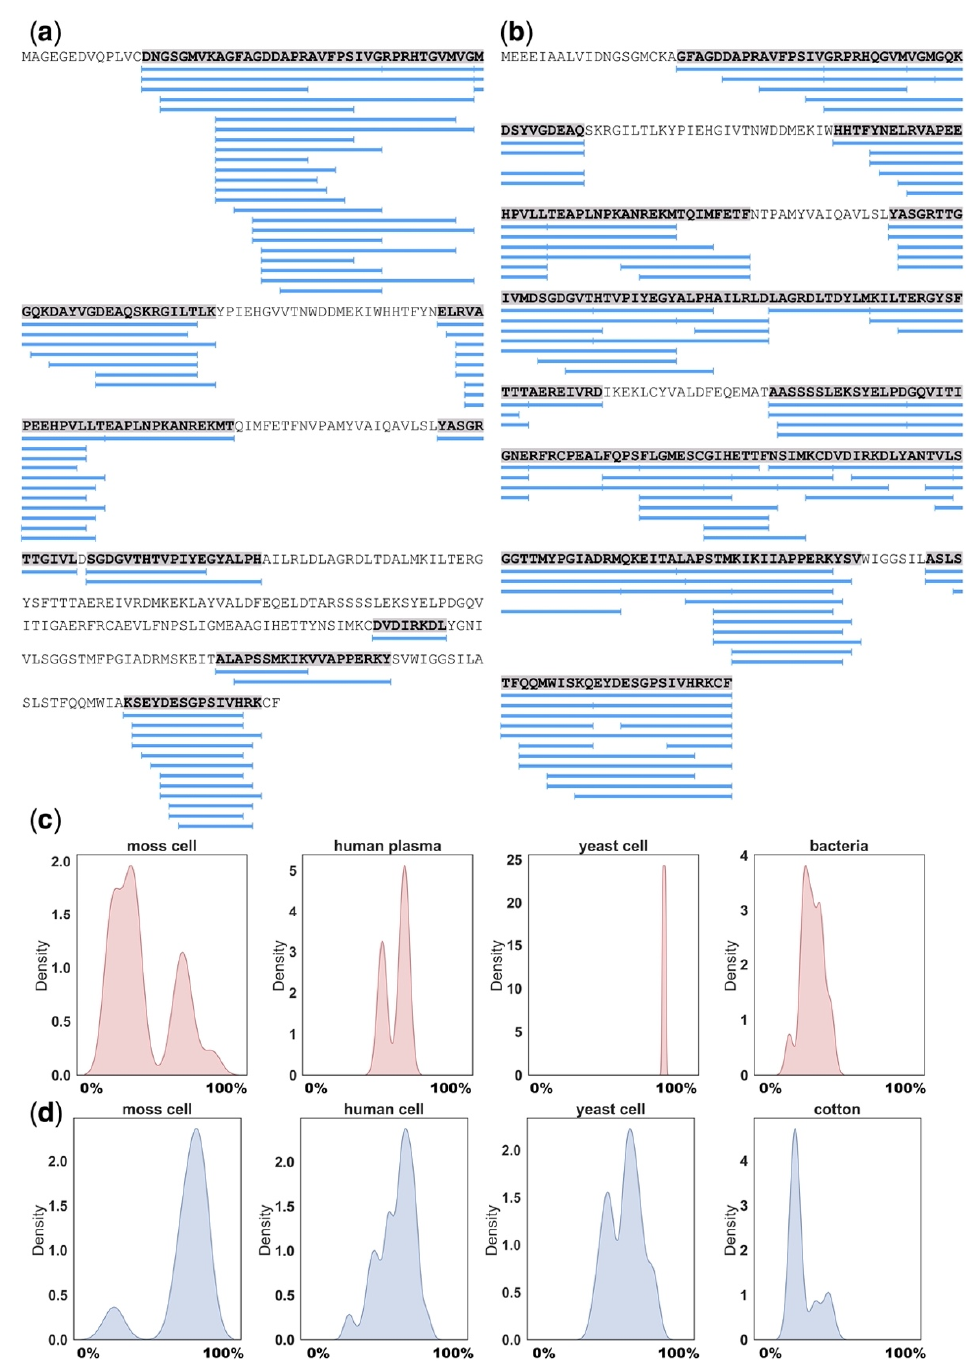
Figure 4. Examples of functional protein degradation patterns. ( a ) MS-identified naturally occurring peptides from P.patens actin (UniProt ID: A9TBG2) and ( b ) human actin (UniProt ID: P63261); density plot showing the MS-based degradation patterns of ( c ) mitochondrial ATP synthase subunit and ( d ) glyceraldehyde-3-phosphate dehydrogenase proteins from the moss P.patens , human, yeast Saccharomyces cerevisiae , bacteria Lactococcus lactis and cotton Gossypium arboreum . These patterns are presented as distribution of occurrence frequency of peptides per corresponding precursor. The positions of each identified peptide were normalized to protein lengths and represented as percentages. The steps of visualizing and analyzing the data in all figures are available in the GitHub code repository: https://github.com/IgorFesenko/Peptidome_review.